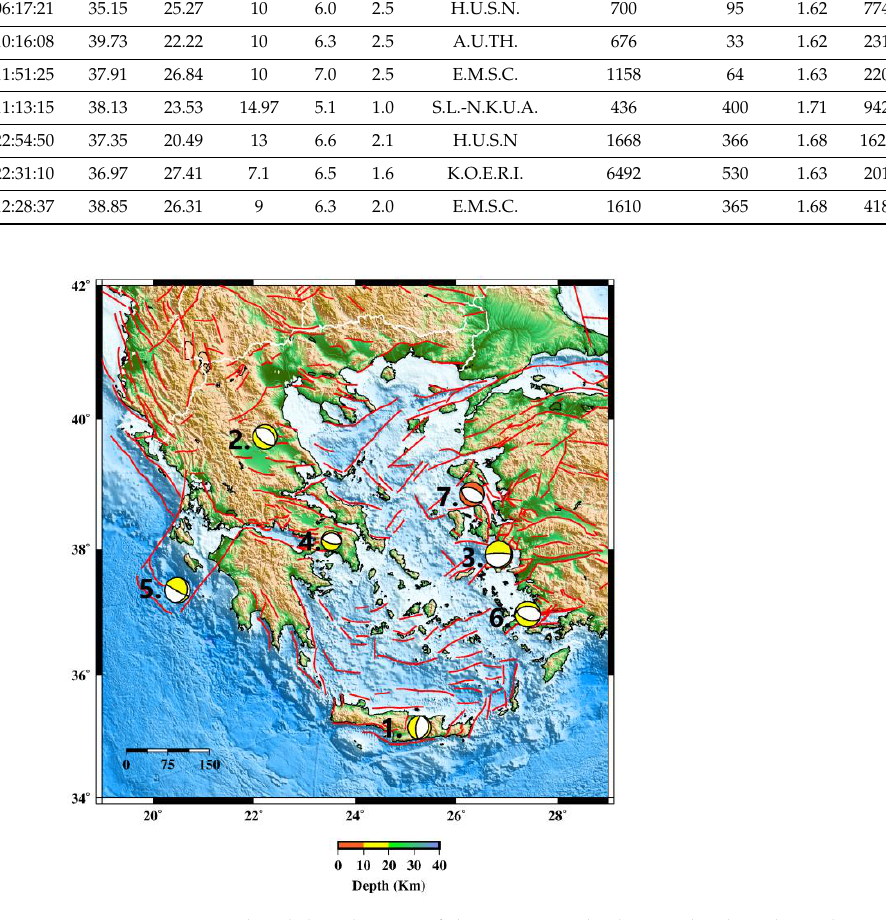
Figure 1. Geographical distribution of the seven studied mainshocks. The index numbers depicted in this figure correspond to the event indices given in Table 1. The colors and sizes of the focal mechanisms (beachballs) are related to the depth and the magnitude of each event. The faults are visualized according to the GEM database [28].